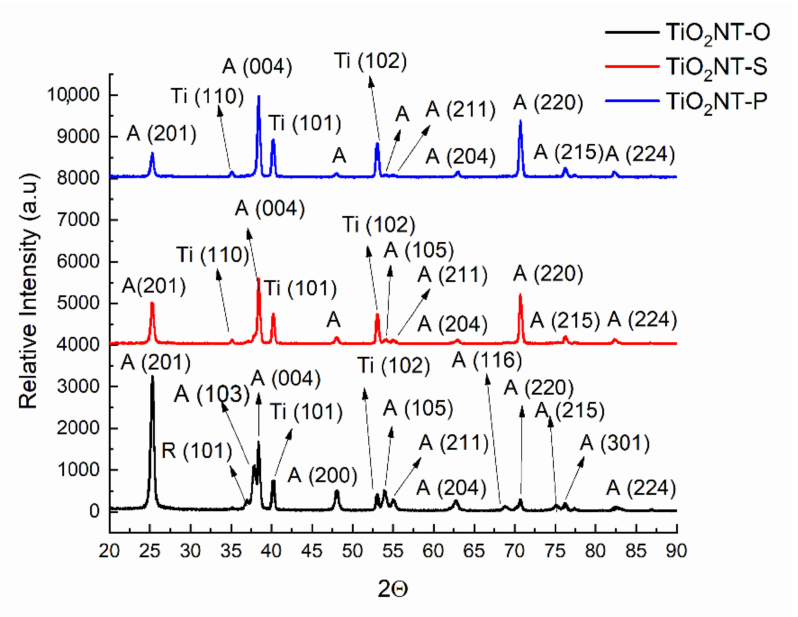
Figure 2. X-Ray Diffraction (XRD) patterns of the three photocatalytic materials. A = anatase, R = rutile, Ti =